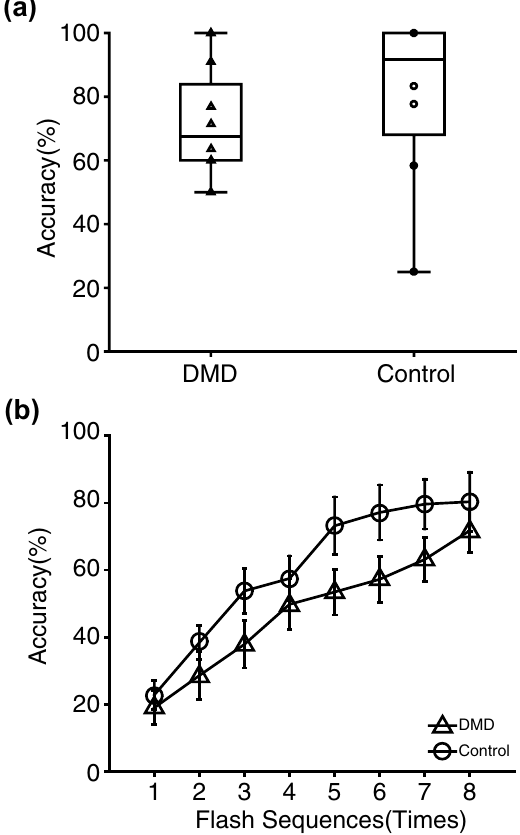
Figure 3. Performance on the character input. (a) Online accuracy of inputted characters (accuracy for the two-step procedure) in the DMD patients was 71.6% and that in the control was 80.6%, with no significant difference between them ( t -test, p = 0.32). Each triangle (DMD) and circle (controls) indicates a data point. (b) Offline accuracy for both groups in each flashing sequence was plotted (triangle: DMD, and circle: